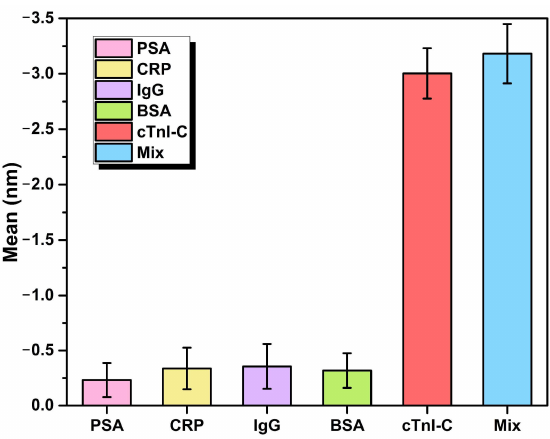
Figure 10. Resonant wavelength shifts of the HGMS with LC sensitization to the interferences and cTnI-C samples with a same concentration of 10 ng/mL for specificity test.